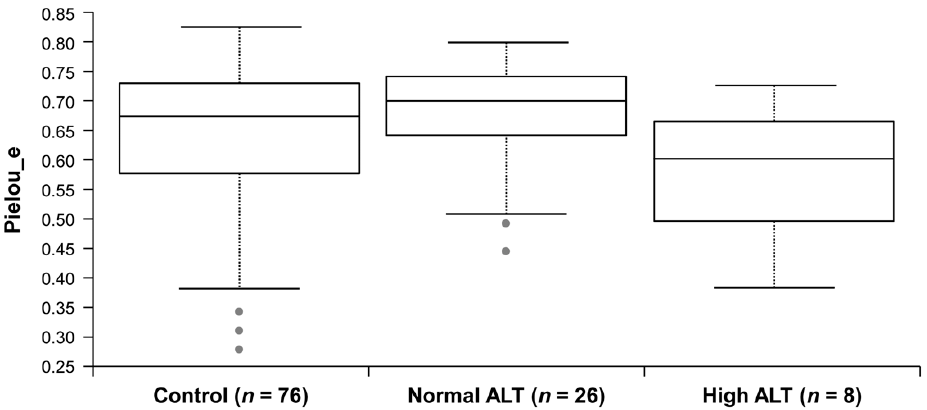
Figure 2. Comparison of Pielou’s Evenness across sample groups. Control versus normal ALT ( p = 0.238, q = 0.238), control versus high ALT ( p = 0.152, q = 0.228), normal ALT versus high ALT ( p = 0.036, q = 0.109). The values of q were calculated with Benjamini–Hochberg correction (FDR).